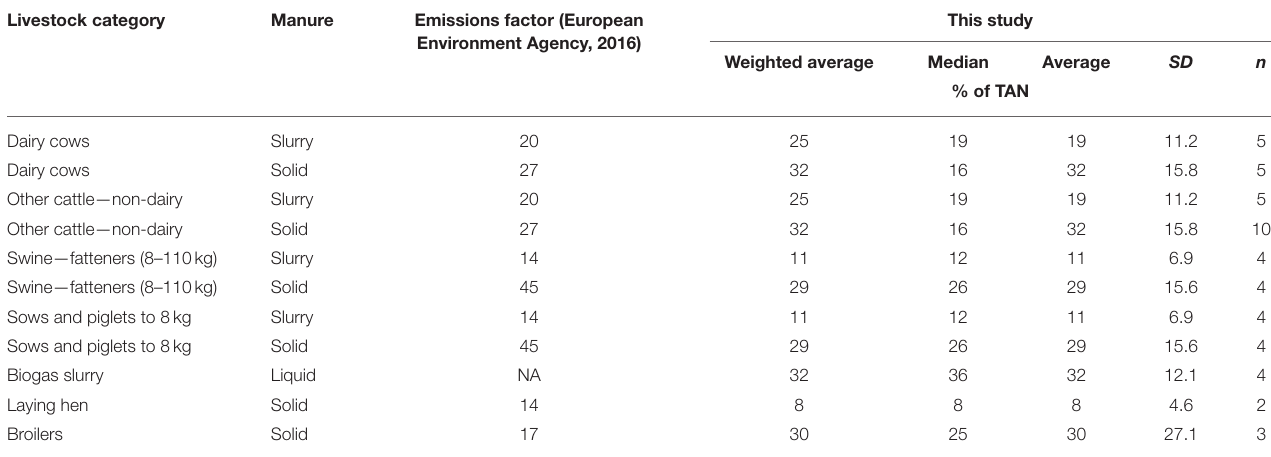
TABLE 6 | Ammonia emission from stored manure given as a % of TAN content in the manure stored outside the animal house (references to articles providing data for each category can be found in the Excel spreadsheets in the Supplementary Material ). Livestock